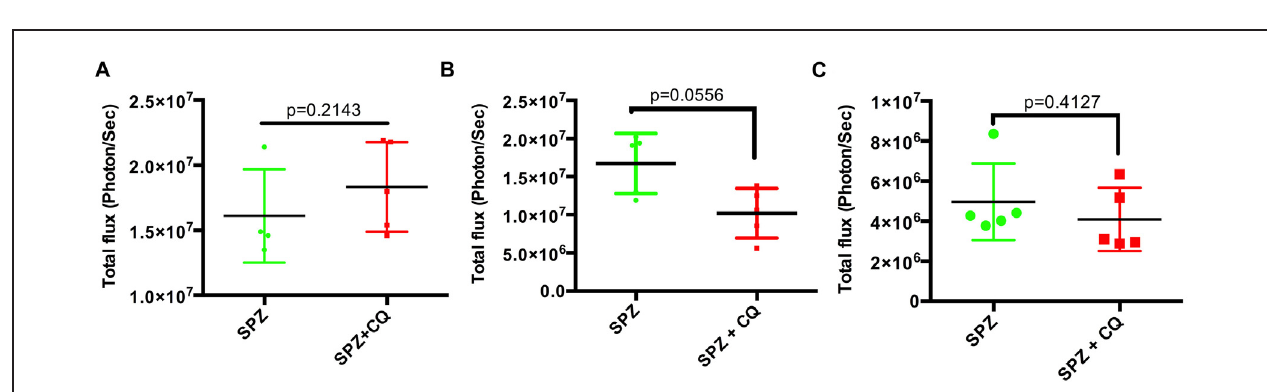
FIGURE 3 | Parasite load in liver at different time points after CQ treatment. Quantification of total flux from whole body imaging of mice (shown in Supplementary Figure S4). n = 4 for SPZ group at 44 hpi (A) , five each for both SPZ and SPZ + CQ at 48 h (B) , and 54 h (C) time points. Graph represents mean ± SD. Mann–Whitney test was performed and p < 0.05 considered as